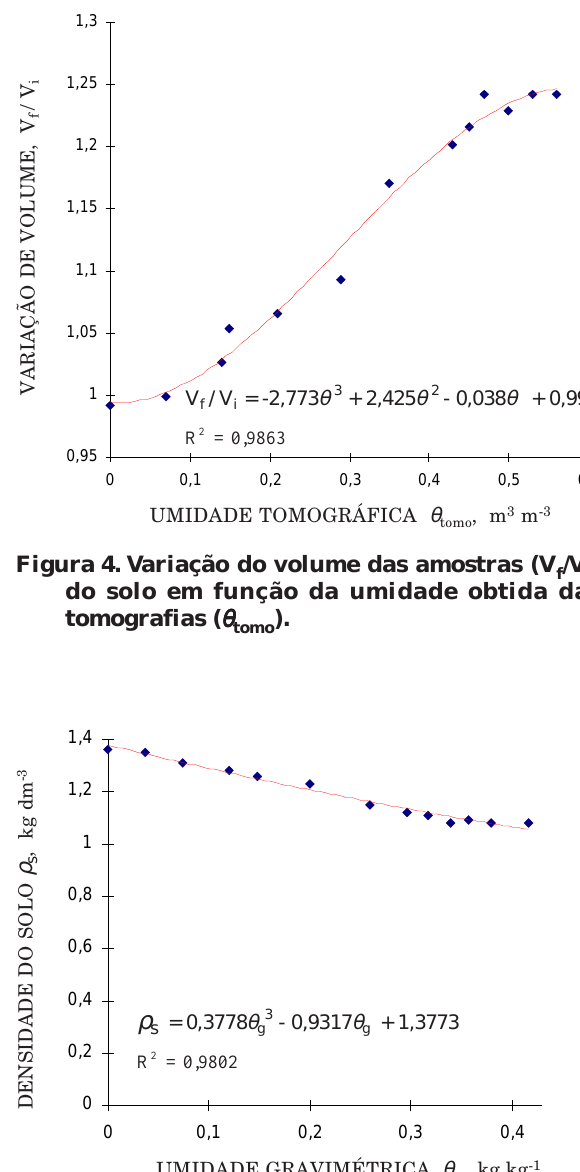
) em s Figura 6. Análise da deformação do solo em função do seu volume específico ( nn nn n